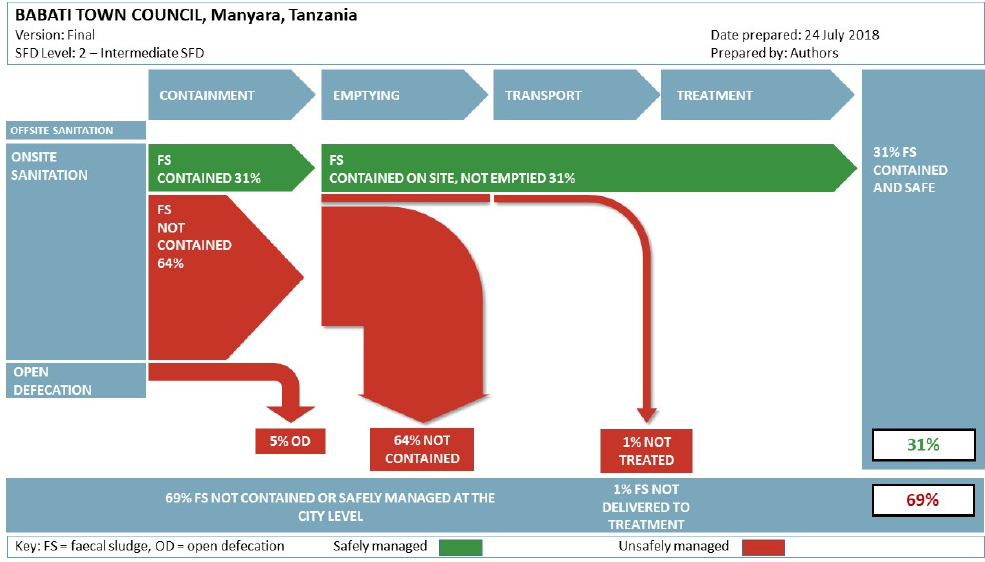
Figure 5. Babati Town fecal sludge flow Figure 5: Babati Town fecal sludge flow diagram.